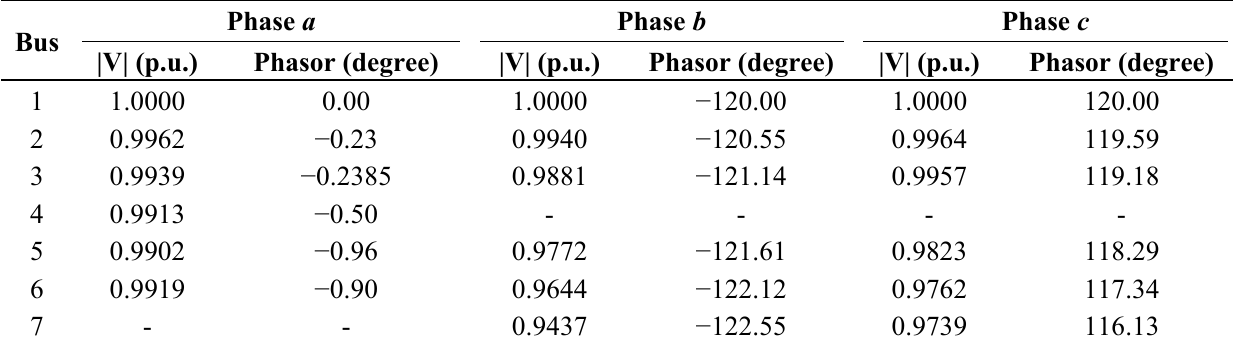
Table 3. Load flow solution of the simple seven-bus test